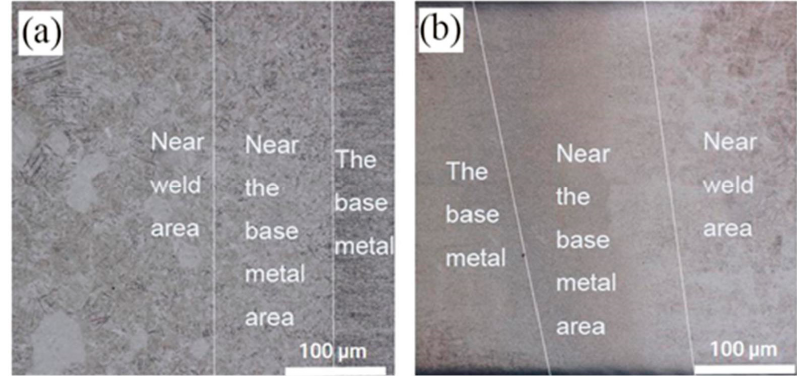
Figure 16. The microstructures of the heat affected zones; ( a ) the underwater weld metal; ( b ) the in-air weld metal.